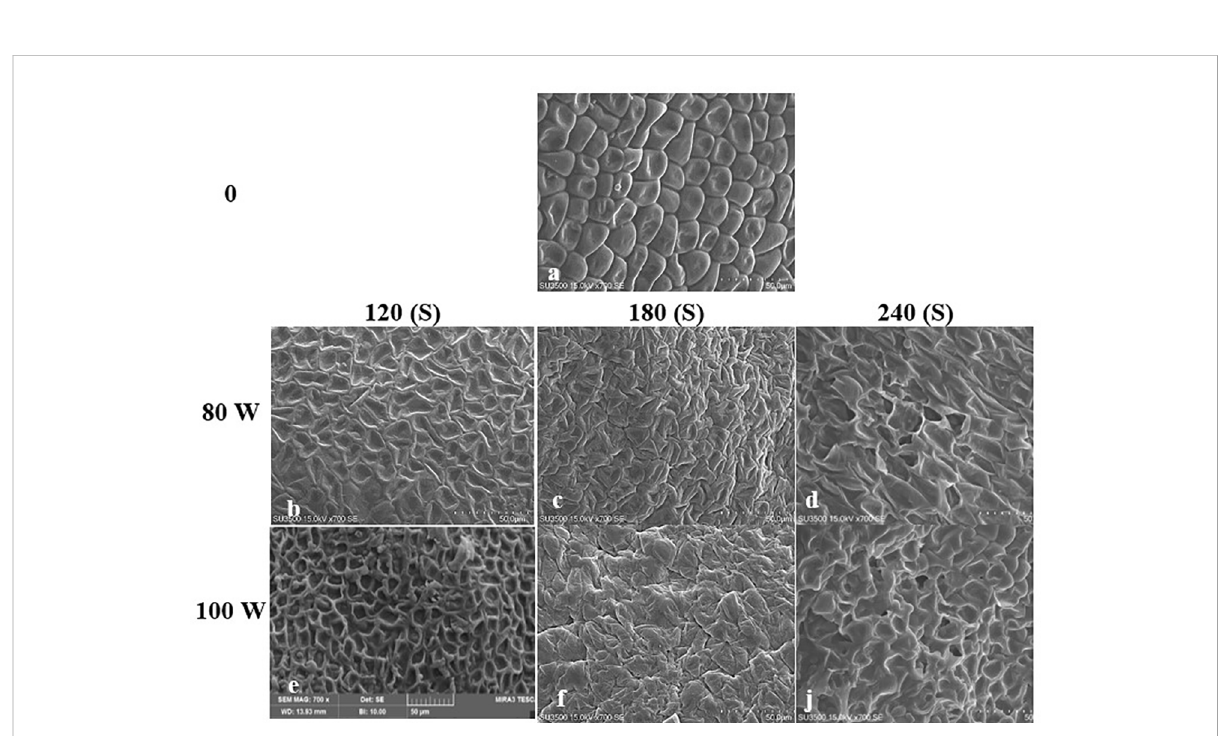
FIGURE 5 Scanning Electron Microscope (SEM) images of the hydro-primed uncovered seed (HUS) surface of S leriifolia under cold plasma. (A) Hydro- primed uncovered seeds (HUS), (B) HUS in 80 W 120s, (C) HUS in 80 W 180s, (D) HUS in 80 W 240s, (E) HUS in 100 W 120s, (F) HUS in W 180s, (J) HUS in 100 W